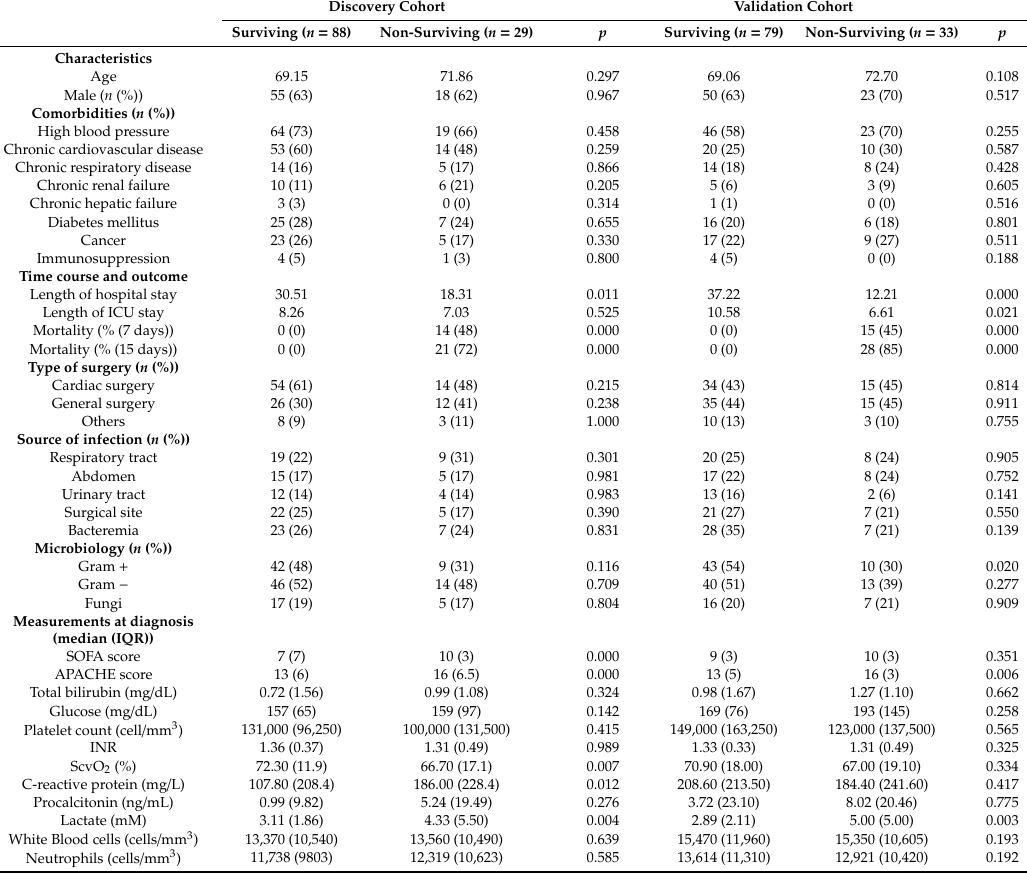
Table 2. Characteristics of postsurgical